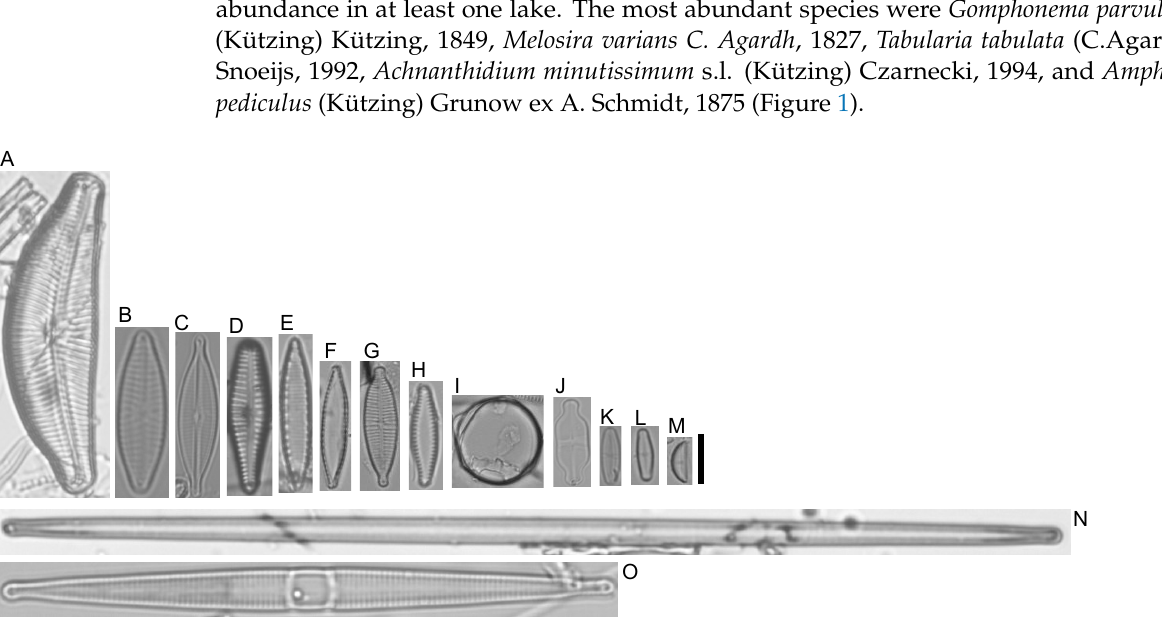
Figure 1. Common taxa in the three lakes of Oporto Natural City Park: A— Cymbella tumida ; B— Navicula veneta ; C— Navicula gregaria ; D— Gomphonema gracille ; E— Nitzschia amphibia ; F— Nitzschia palea ; F— Gomphonema parvulum ; H— Pseudostaurosira brevistriata ; I— Melosira varians ; J— Achanthidium exiguum ; K— Achnanthidium saprophilum ; L— Achnanthidium minutissimum ; M— Amphora pediculus ; N— Ulnaria ulna ; O— Ctenophora pulchella ; Scale bar = 10 µm.